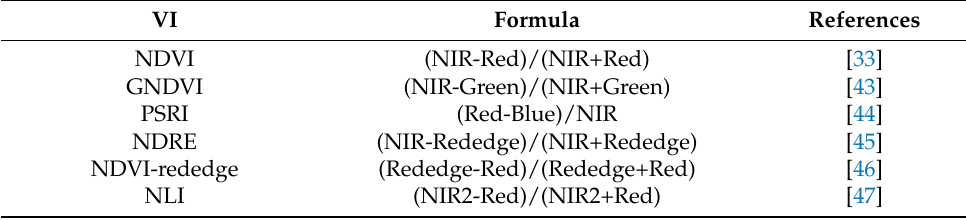
Table 2. Vegetation indices used to monitor the grain-filling process of winter wheat. VI